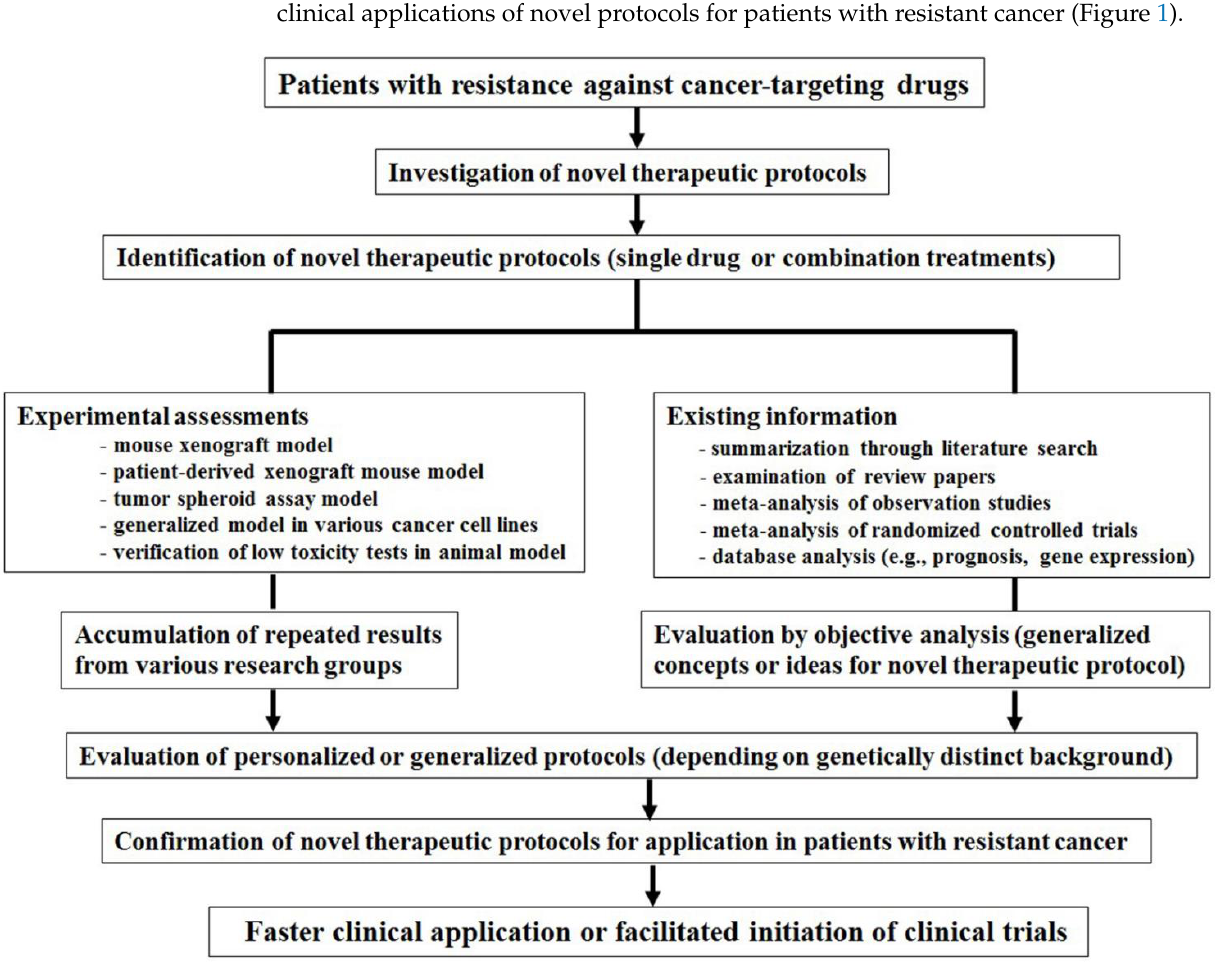
Figure 1. Scheme summarizing the initiation of faster clinical trials to apply novel therapeutic protocols for cancer-targeting drugs against resistant cancer. To initiate faster clinical trials, completing experimental tests and reviewing existing information can increase the possibility of initiating faster clinical applications for novel therapeutic protocols. Repeated and accumulated results will support the rapid clinical application of novel therapeutic protocols for cancer-targeting drugs against resistant cancer.